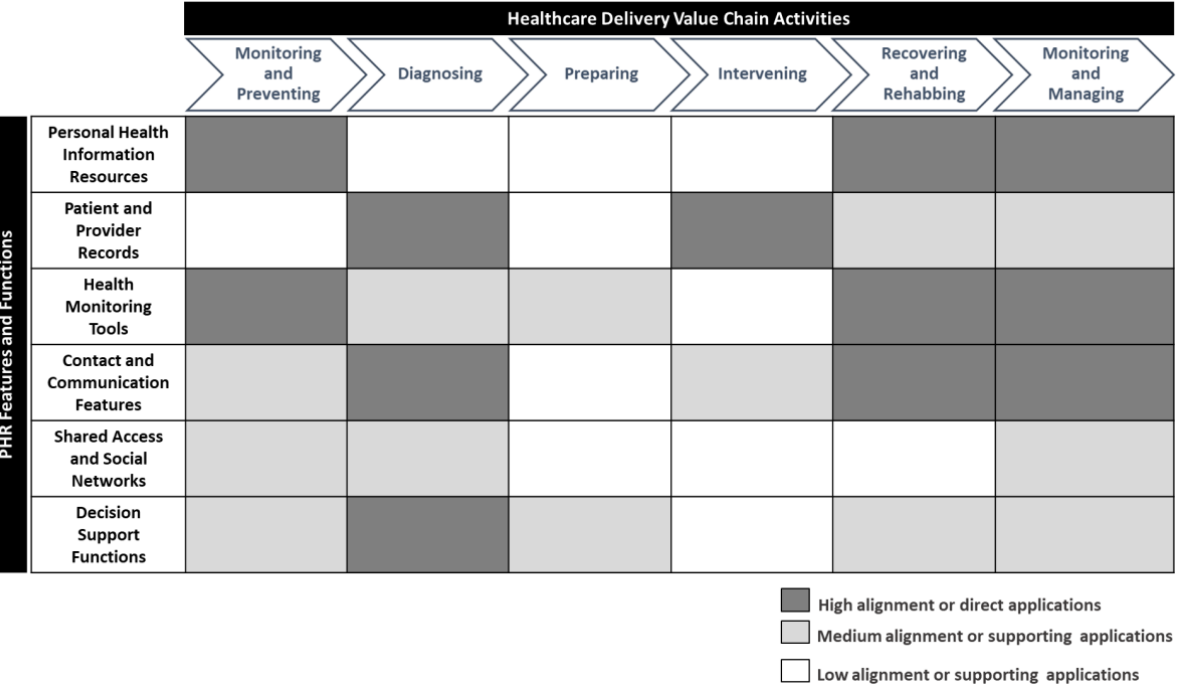
Figure 2. Personal health record consumer value: a mapping of personal health record functionality to the health care delivery value chain. PHR: personal health